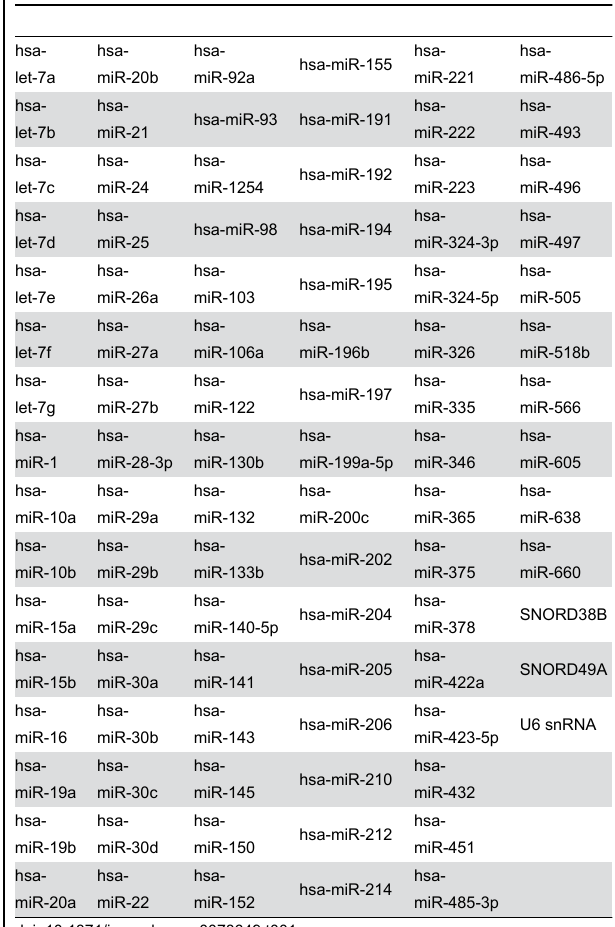
Table 1. List of miRNA probes used to profile plasma samples from lung SCC patients.